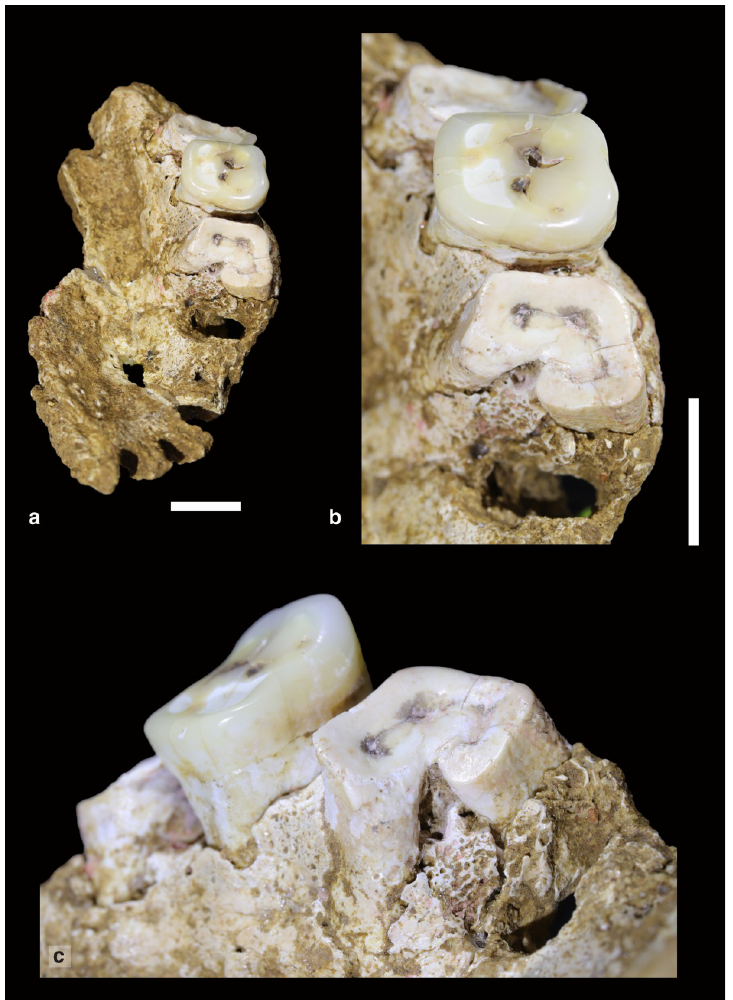
Fig 9. Dental pathologies in Maros-LBB-1a. (a) Inferior view of the right palate. Note the inflammation of the interproximal septa at all tooth sites, particularly marked at the sites of the premolar sockets, including the resorbed first premolar; (b) close-up of the inflammation of the interproximal septa at the second premolar site, showing also the rough interior surface of the socket. Note also the mesio-lingual to bucco-distal striation on the third molar; (c) close-up of the inflammation of the alveolar bone at the second premolar site, and slighter inflammation of the interproximal septa between the first and second molars. Scale bars are 10 mm.